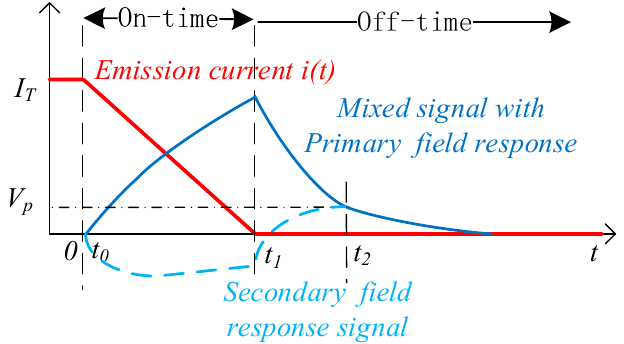
Figure 1. Schematic diagram of the transient electromagnetic response signal. i T ( t ) is the emission current in the TX coil; the secondary field excited by the underground anomalies is mixed with the primary field excited by the emission current in the TX coil and therefore expands the dynamic range of the signal.